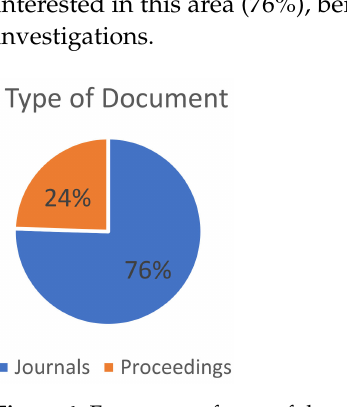
Figure 4. Frequency of type of documents (Journals and Proceedings).